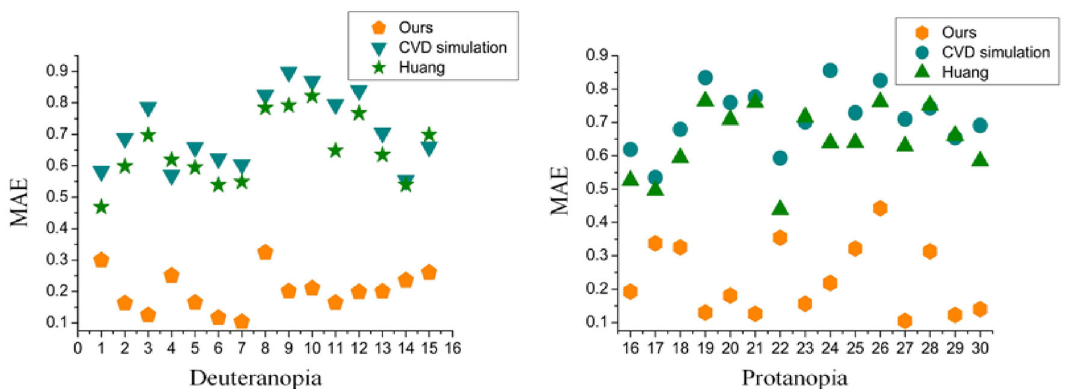
Fig. 13 Comparison of PR curves for different images. (a, c) compare our method with a direct CVD simulation image. (b, d) compare our method with Huang’s color correction method. (a, b) Green blind images. (c, d) Red blind images.